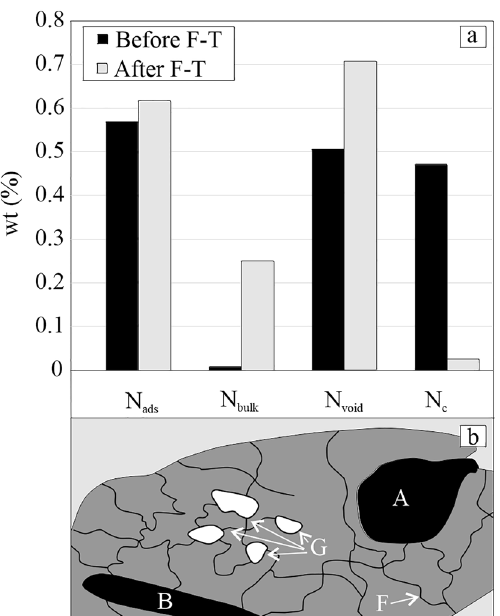
Figure 4. Pore size distribution by indicative rock pore structure method before and after 100 F–T ( a ) Illustrated pore structure of the BH(A) andesite ( b ): (A) N void —pores with narrow necks, (B) N void —blind pores; (G) N c —isolated pores which are not accessible to water; (F) N ADS —micropores and